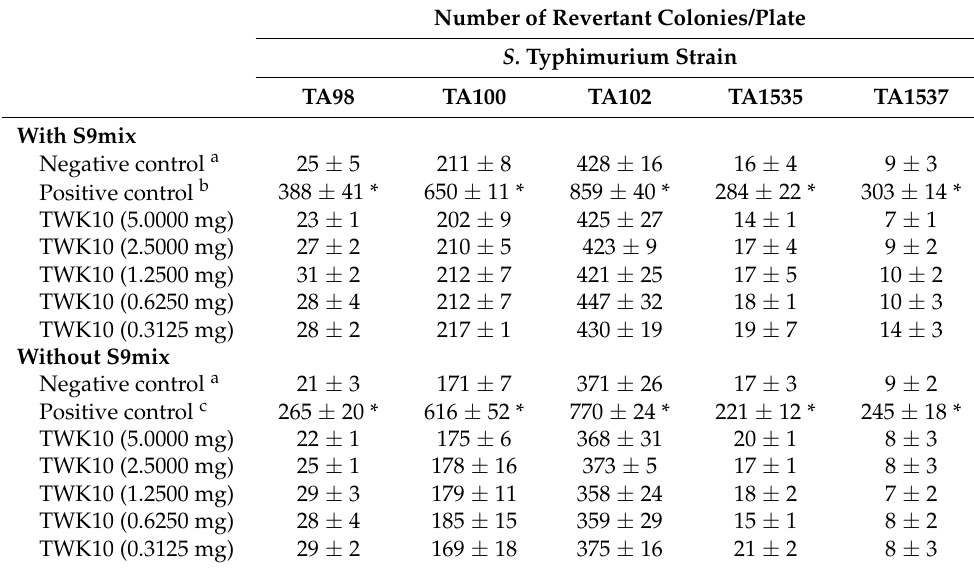
Table 3. Ames test results for TWK10 using S. Typhimurium strains.